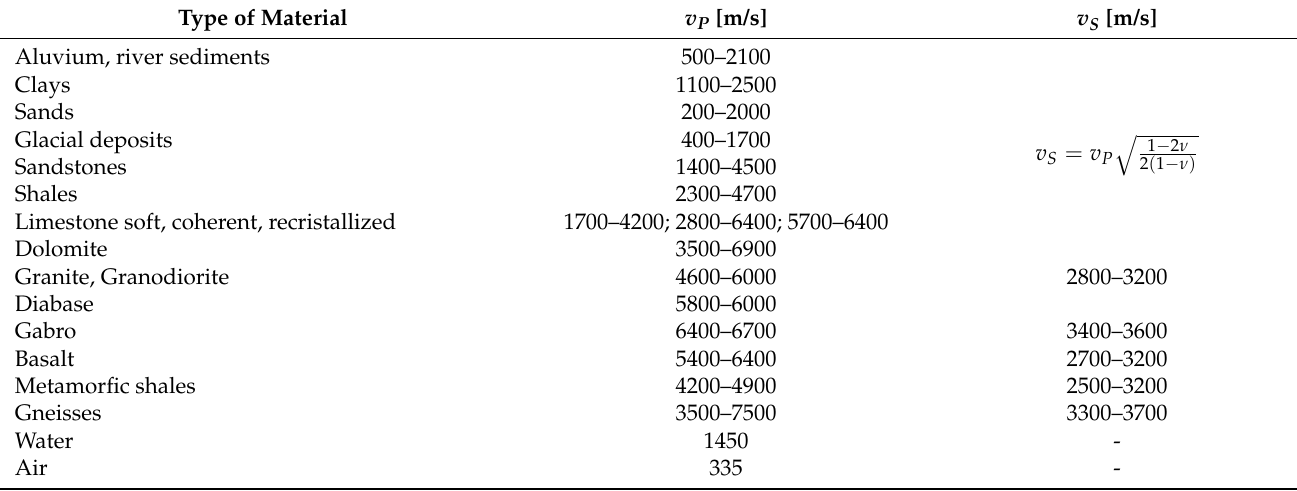
Table 2. Typical values of the propagation velocities of the longitudinal and transverse waves in selected geotechnical media (based on [50]).